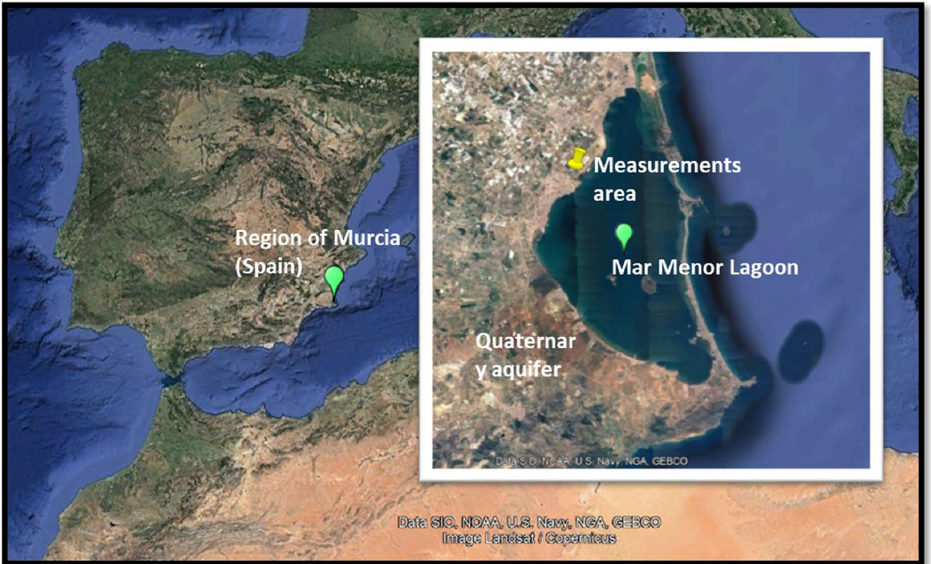
Figure 10. Location of the study area and location of measurement wells in front of Mar Menor (Google Earth Pro).